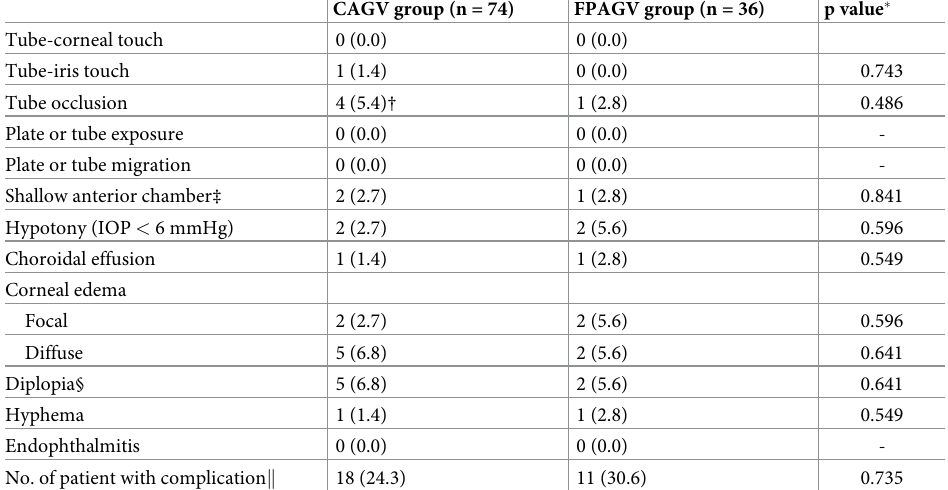
Table 3. Postoperative complications.